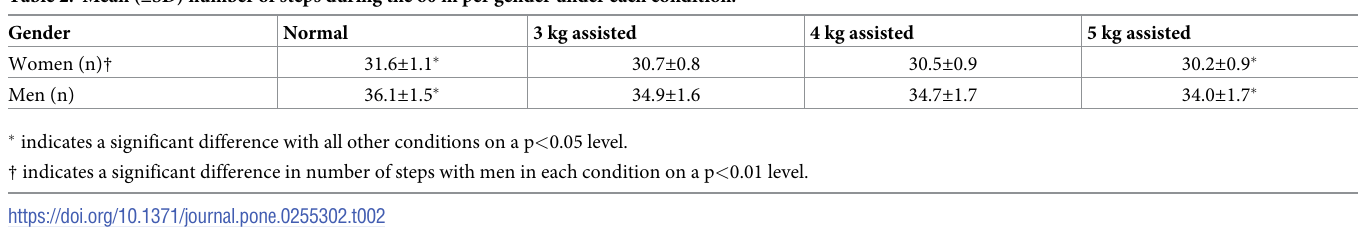
Table 2. Mean ( ± SD) number of steps during the 60 m per gender under each condition.